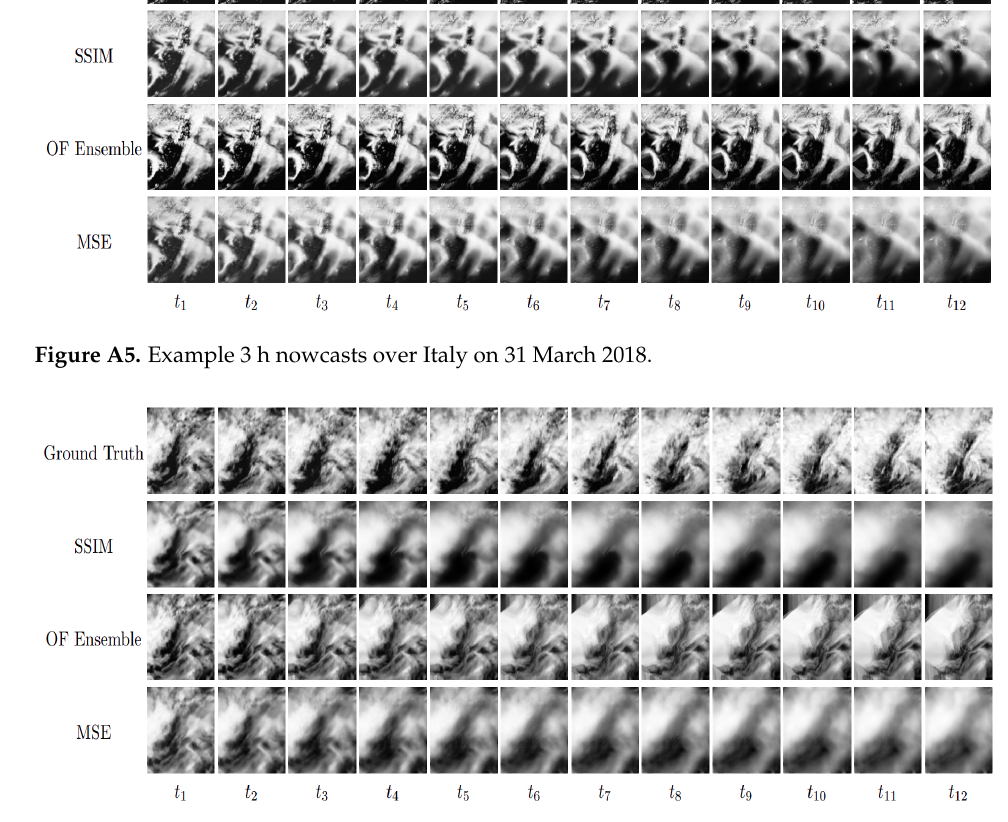
Figure A6. Example 3 h nowcasts over Hungary on 28 September 2019.